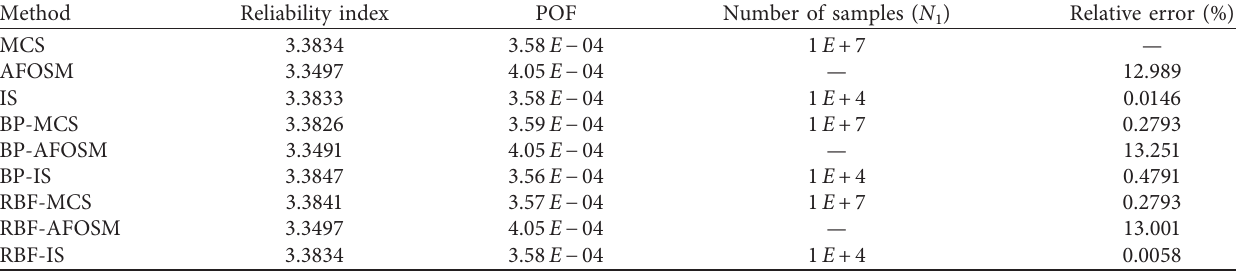
Table 3: Comparison of the reliability index and POF from different reliability analysis methods with an ANN sample size of 300.